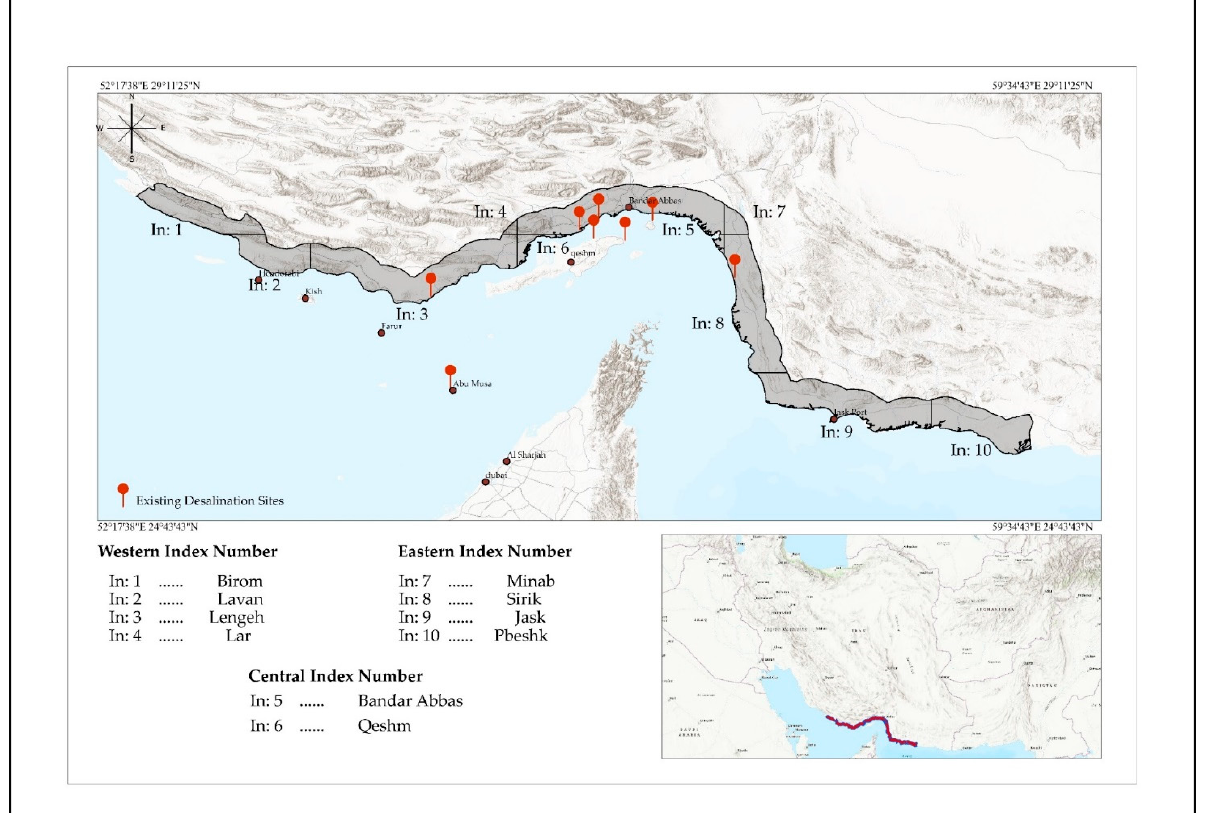
Figure 1. The spatial sub-setting of Hormozgan province based on Iran’s National Cartographic Center’s